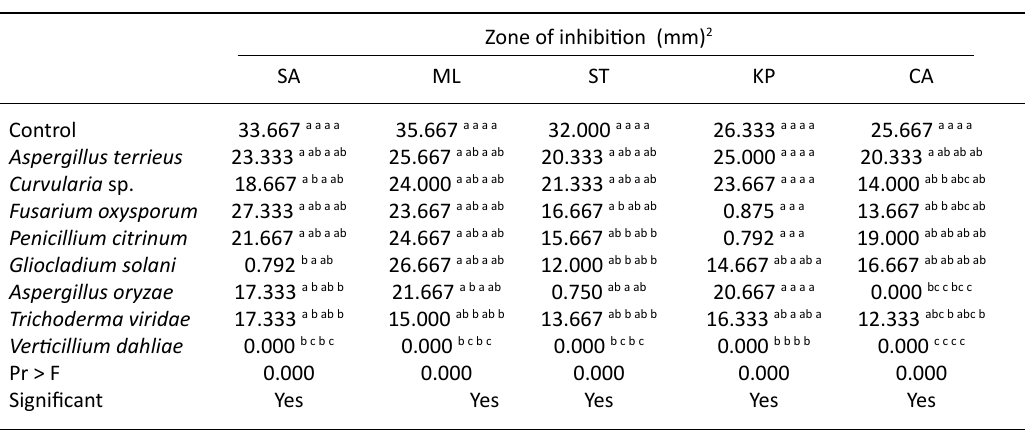
Table 4. Antimicrobial activity of isolated endophytic